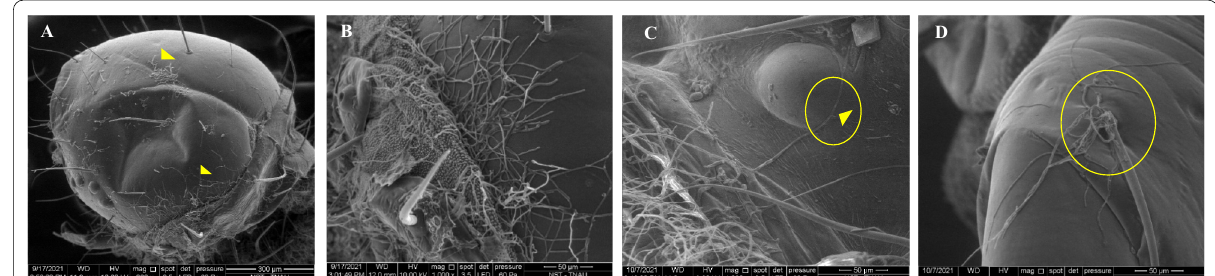
Fig. 6 SEM images of second instar of Spodoptera frugiperda infected with Metarhizium anisopliae (96 hpi). a . Extensive hyphal development in head region (arrowheads). b . Close up of hyphal penetration site in head region (circle). c . Stemmata region with penetrating hypha (circle), appressorium (arrowhead). d . Penetration of hypha through seta socket in thoracic leg (circle)